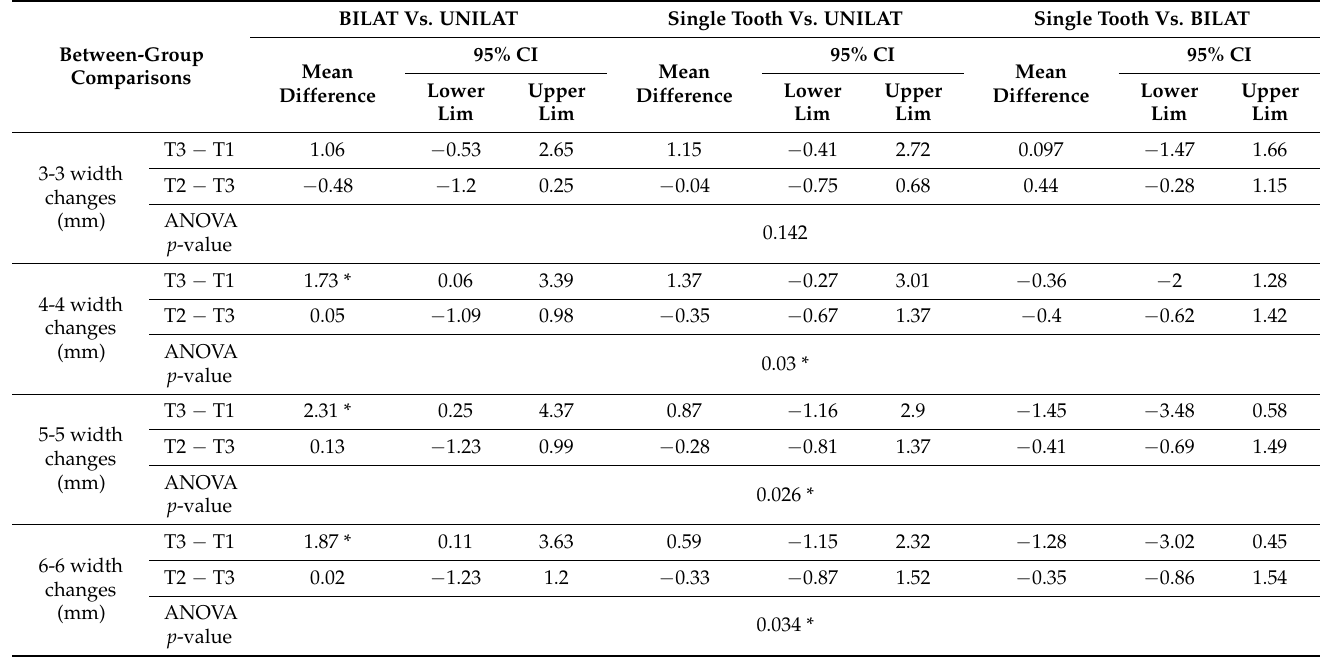
Table 3. Between-group comparisons of the efficacy (T3-T1) and predictability (T2-T3) of expansion at canine, premolar, and molar levels. T1: initial width; T2: predicted final width; T3: observed final width. 3-3: intercanine, 4-4: inter-first premolar, 5-5: inter-second premolar, 6-6: intermolar, UNILAT: unilateral crossbite group, BILAT: bilateral crossbite group, single tooth: single-tooth crossbite group, Vs.: versus, CI: Confidence interval, Lim: limit, *: statistically significant difference, p ≤ 0.05.